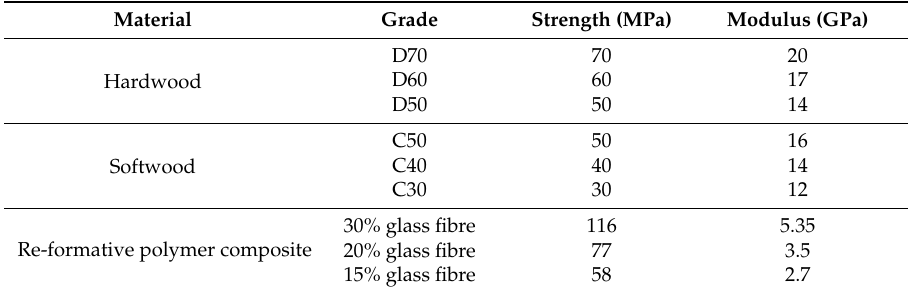
Table 1. Strength and modulus for different volume fraction glass fibre re-formative polymer composite, and for differing grades of hardwood and